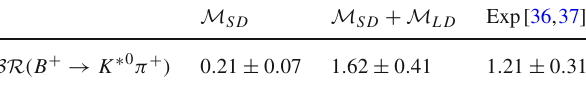
Table 8 Branching ratio values (units 10 − 5 ) of the B + → K ∗ 0 π +